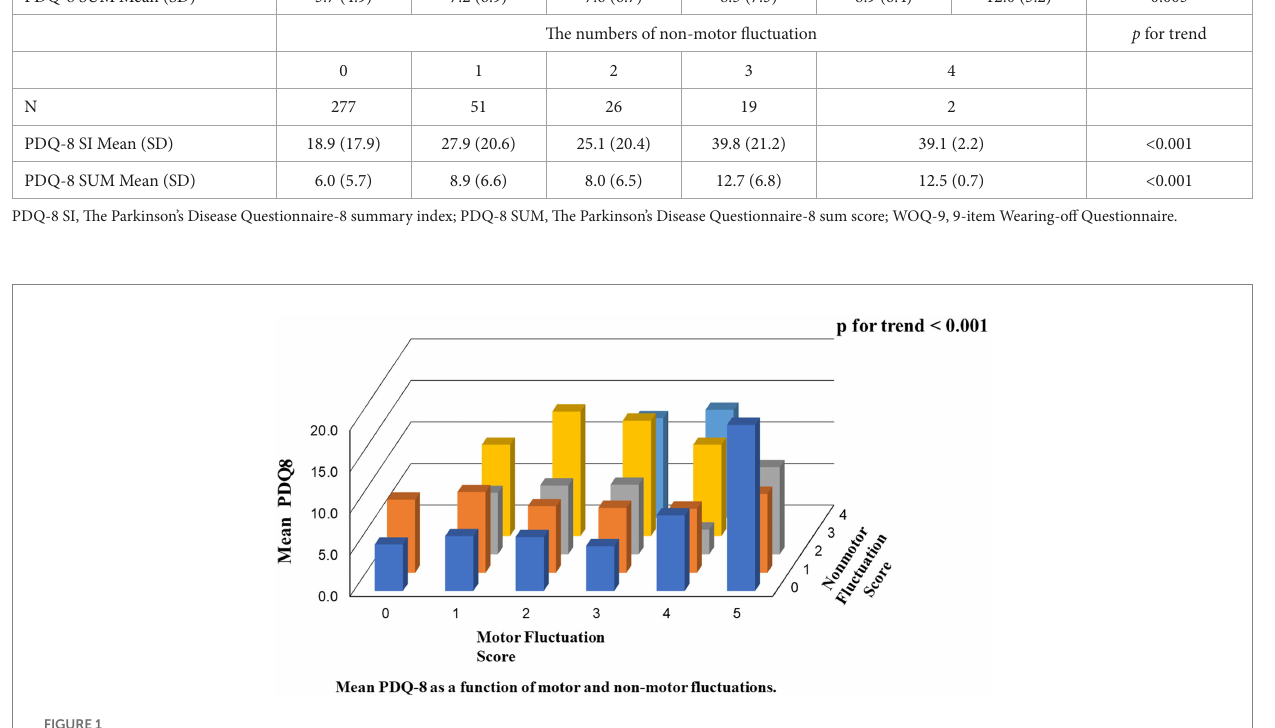
FIGURE 1 Motor and nonmotor